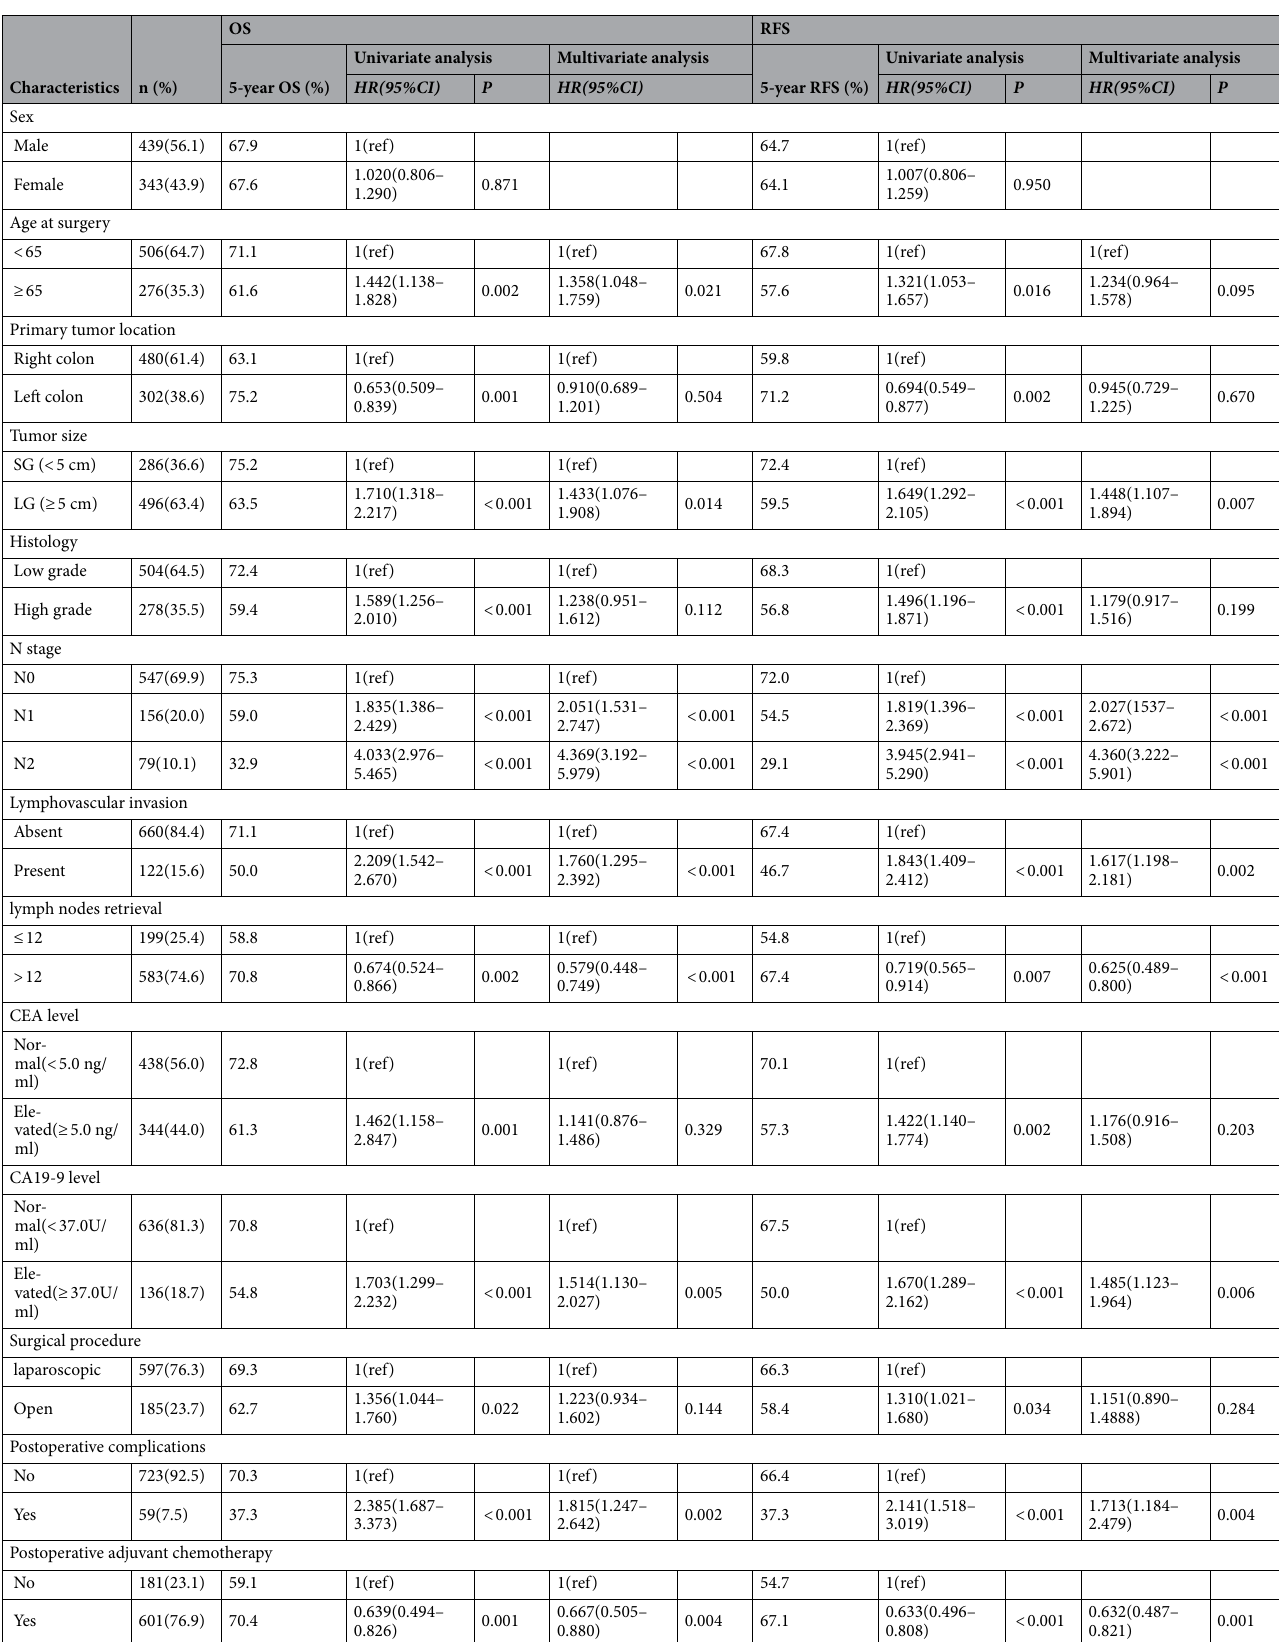
Table 2. Univariate and multivariate survival analysis in the whole study